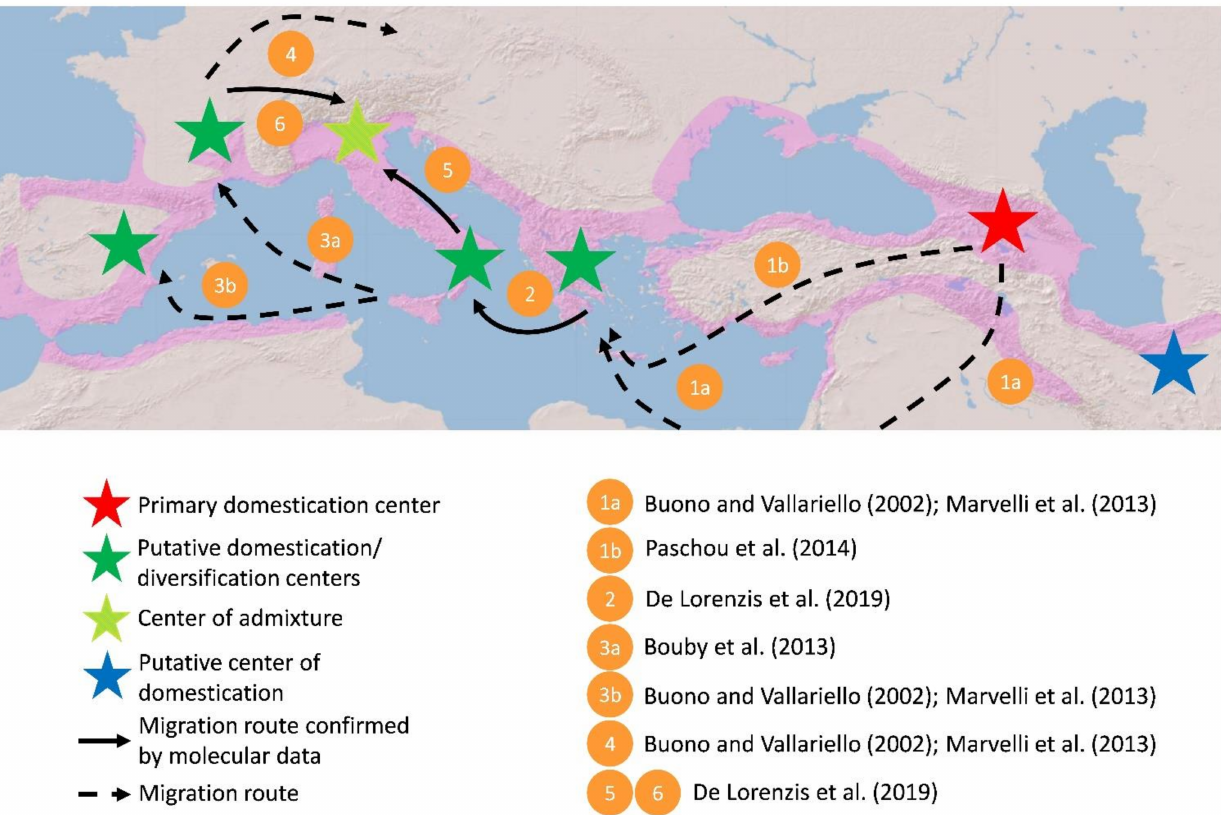
Figure 3. Map depicting probable grapevine domestication and diversification centres (stars) and the main grapevine migration routes (arrows). Pink area shows the distribution range of wild grapevine. According to many researchers, the domestication of grapevine took place around Mount Ararat in the Caucasus (red star). Its diffusion around the Mediterranean basin could have followed three main pathways. The first pathway goes from Mount Ararat to Mesopotamia, Egypt and Greece, considered a secondary domestication centre (green star), in the Bronze Age (arrow 1a). Others agree that grapevine arrived in Greece through Anatolia (arrow 1b). The second route starts from Greece and goes to Magna Graecia (Sicily, Southern Italy) (green star), France (Marseille) (green star) and Spain (green star) under the influence of the Greeks, Etruscans and Phoenicians (arrows 2, 3a and 3b). The third route goes from France to the north of Europe, mainly through the Rhone, the Rhine and the Danube, under the influence of the Roman Empire (arrow 4). Recently, Northern Italy (striped star) has been highlighted as an admixed centre of the Southern Italian (arrow 5) and Central European (arrow 6)